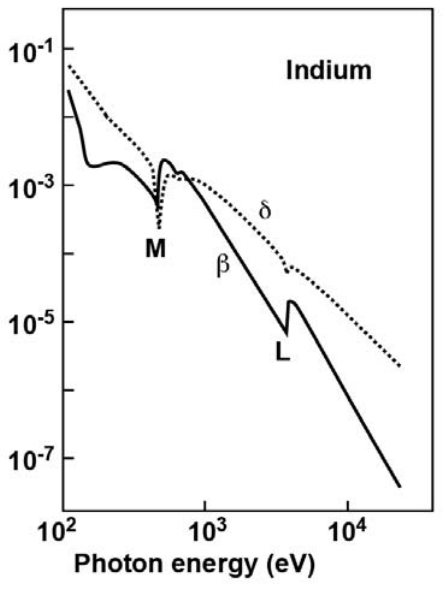
Figure 13. Plots of the  and  factors as a function of the photon energy for indium. The features corresponding to the L and M thresholds are